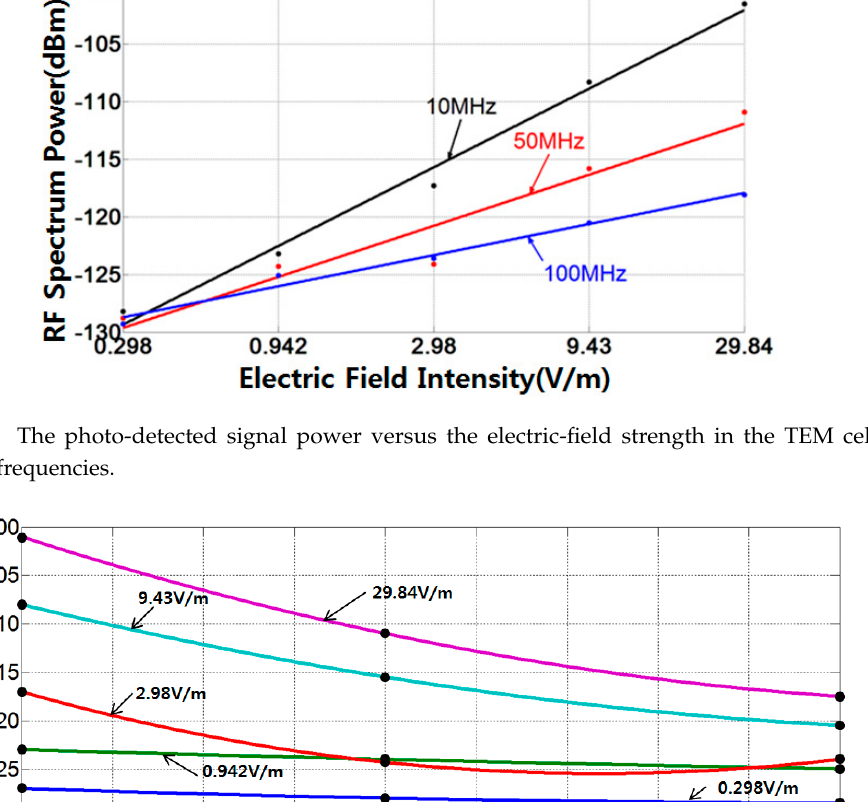
Figure 11. The frequency response of the sensor.